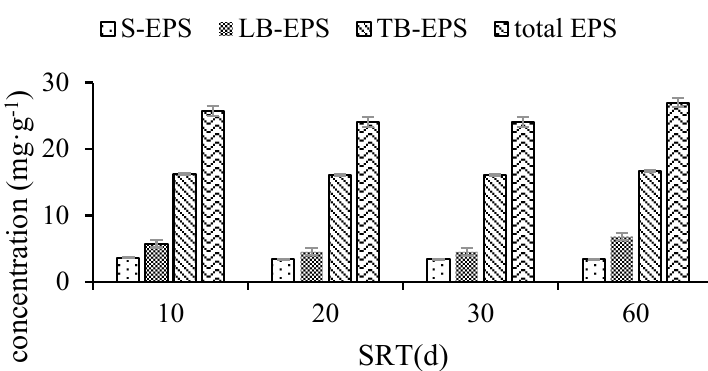
Figure 2. EPS distributions under the four different SRT conditions.